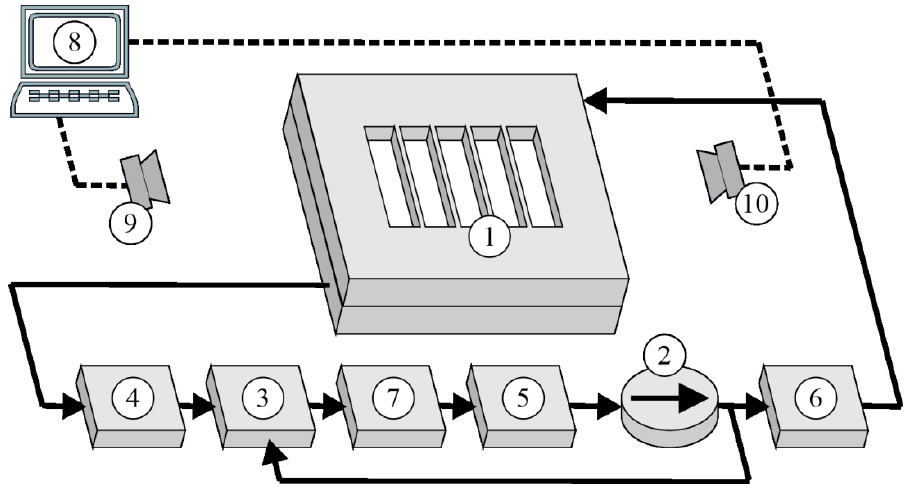
Figure 1. The experimental apparatus: 1—test section, 2—gear pump, 3—compensating tank, 4—heat exchanger, 5—filter, 6—Coriolis mass flow meter, 7—deaerator, 8—PC computer, exchanger, 5—filter, 6—Coriolis mass flow meter, 7—deaerator, 8—PC computer, 9—infrared camera, 9—infrared camera, 10—high-speed digital camera. 10—high-speed digital